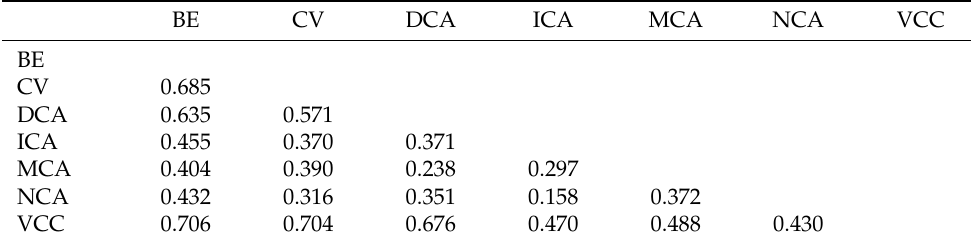
Table 4. Heterotrait–Monotrait (HTMT)